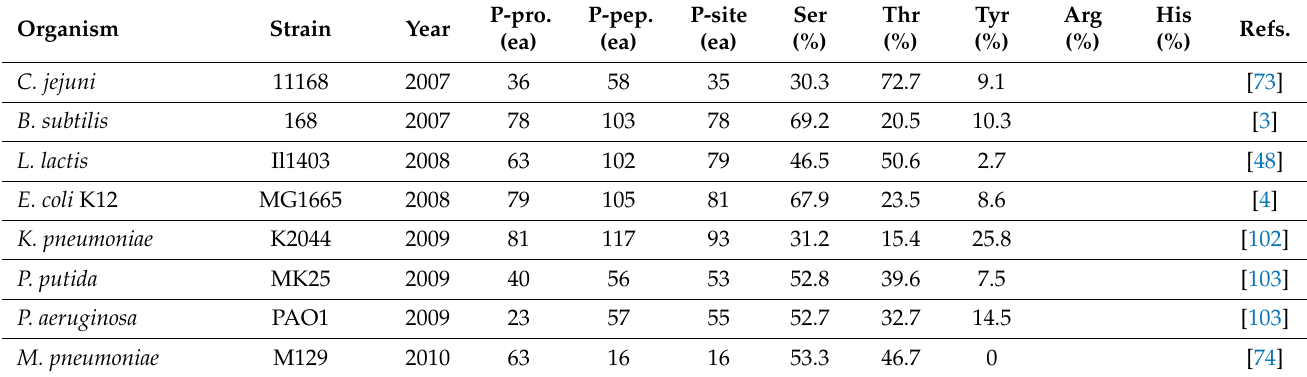
Table 1. Bacterial Ser/Thr/Tyr/His/Arg phosphoprotemics